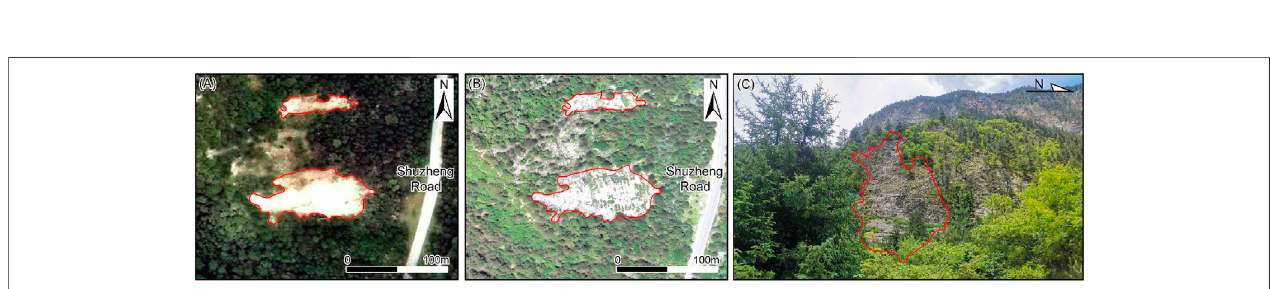
FIGURE11| Landsliderestorationaftertreatment (A) Coseismiclandslidesin2017 (B) Thelandslideswithvegetationin2020 (C) Fieldphotoshowingthelandslide with vegetation.